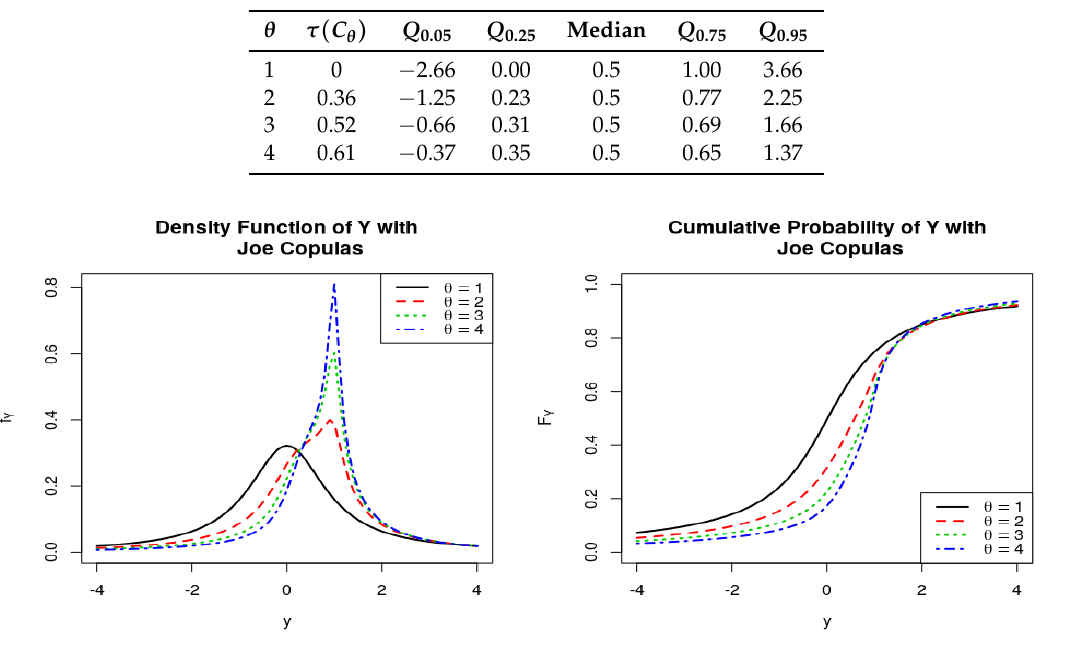
Figure 11. PDFs and CDFs of the ratio Y = X 1